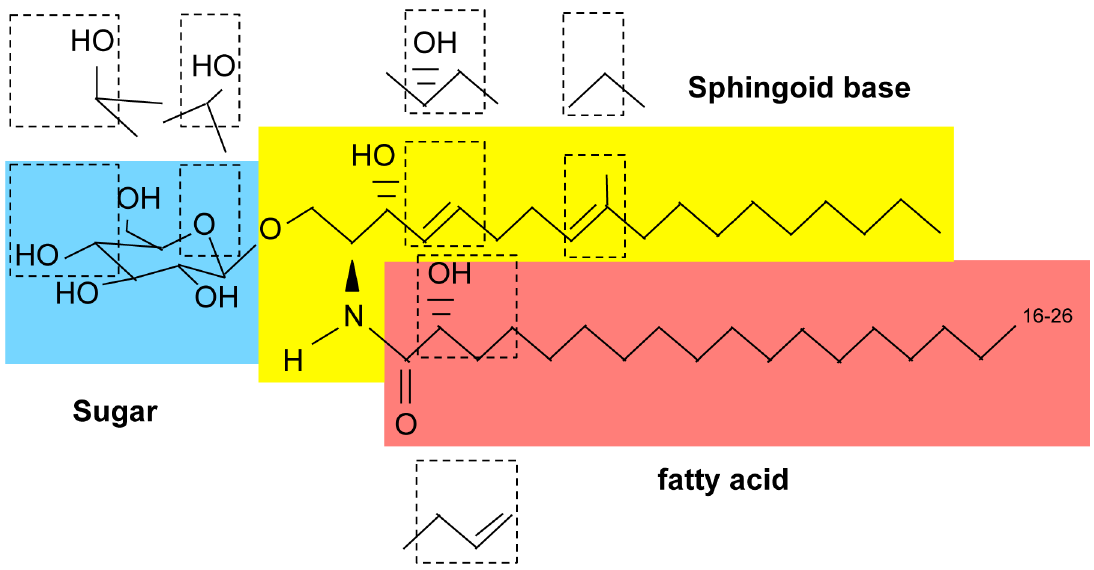
Figure 1. Basic structure of glycosphingolipids. First, a long-chain sphingoid base backbone (distinguished from glycerolipids which have a glycerol backbone) is linked to a fatty acid via an amide bond with the 2-amino group and to a polar head group at the C1 position via an ester bond, forming ceramide. Second, ceramide is linked to a sugar (glucose, galactose, or inositol) via a b -glycosidic bond between the hemiacetal group of the sugar and the C1 hydroxyl group of